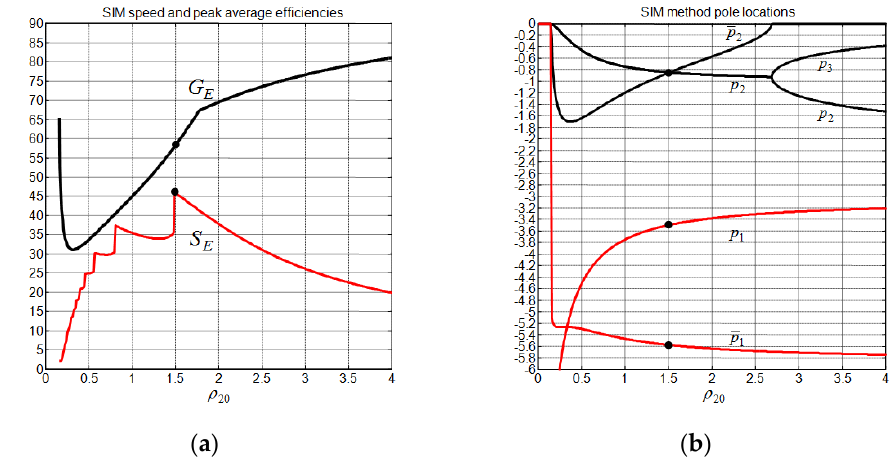
Figure 11. Analysis of the SIM method performance. ( a ) Speed and peak efficiencies; ( b ) pole locations.